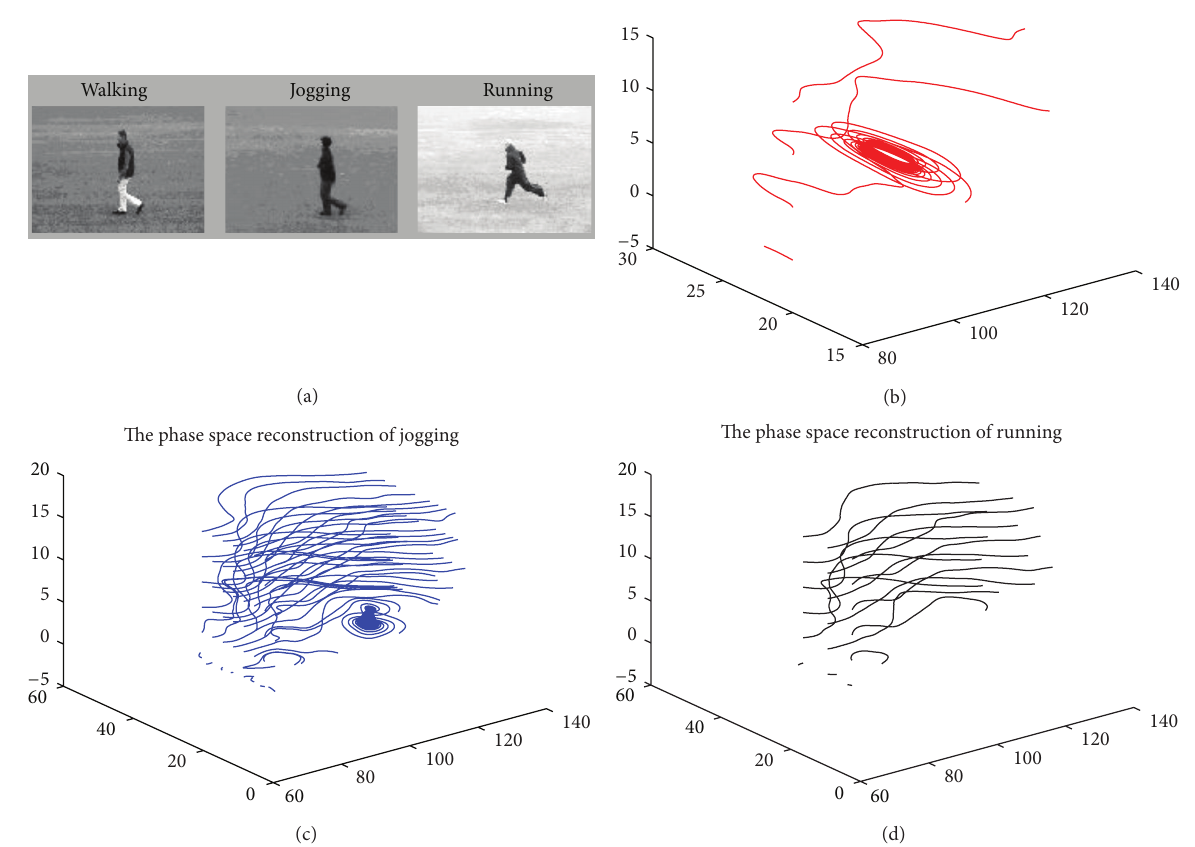
Figure 3: Examples of the reconstructed phase space of the missing data. Hip rotations for walking, jogging, and running actions in the KTH dataset [33]. (a) shows original images. (b) shows the result of reconstructing the reconstructed phase space of the missing data. (b1) shows the phase space reconstruction of right foot motion. (b2) shows the phase space reconstruction of right elbow motion. (b3) shows the phase space reconstruction of right elbow motion. (c) shows the reconstructed phase space of the total occlude joint point. (c1) shows the phase space reconstruction of walking. (c2) shows the phase space reconstruction of jogging. (c3) shows the phase space reconstruction of running.